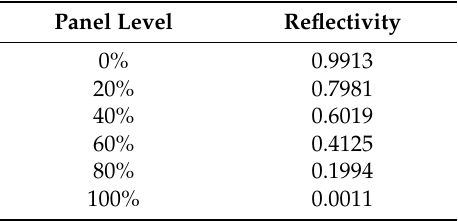
Table 2. The expectation of offset of six kinds of reflectivity at distance 1.4 m.